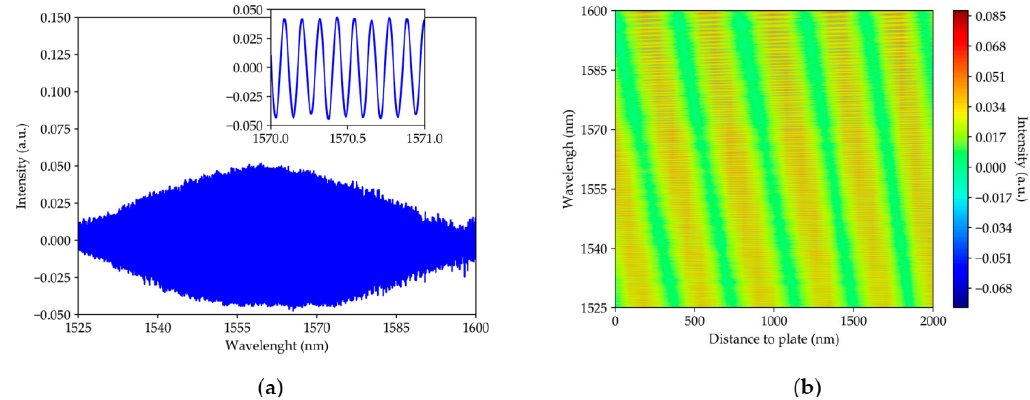
Figure 7. The two interferometers with a length of 6.1 ± 0.2 mm: ( a ) spectrum at the beginning of measurements, and ( b ) intensity as a function of distance to the reflecting surface and as a function of wavelength.